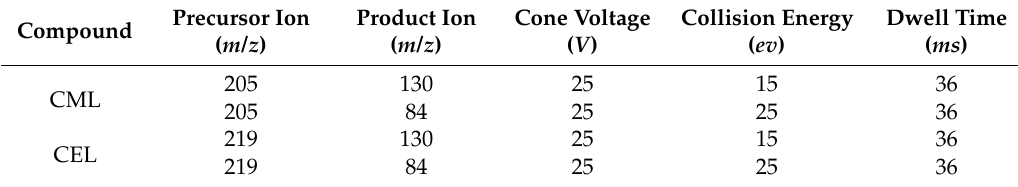
Table 6. UPLC-MS settings for multiple reaction monitoring